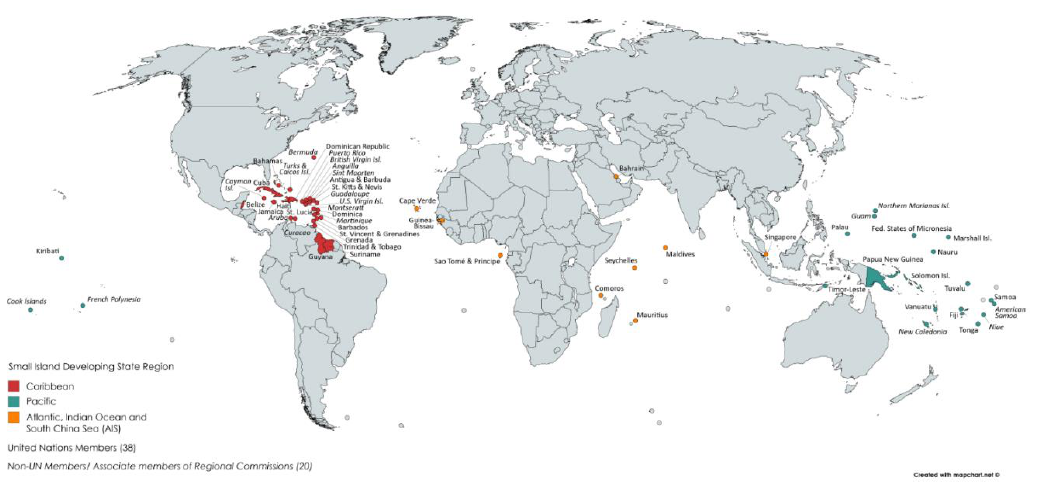
Figure 1. World map showing the 58 Small Island Developing States (SIDS). Countries and territories / topics / sids / list. (Map from Hickey and Unwin as listed at: sustainabledevelopment.un.org/topics/sids/list. (Map from Hickey and Unwin [15].) as listed at: sustainabledevelopment.un.org